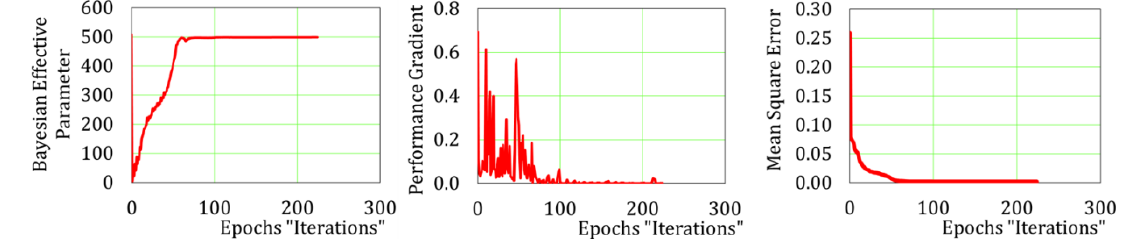
Figure 15. Training parameters’ states during learning.